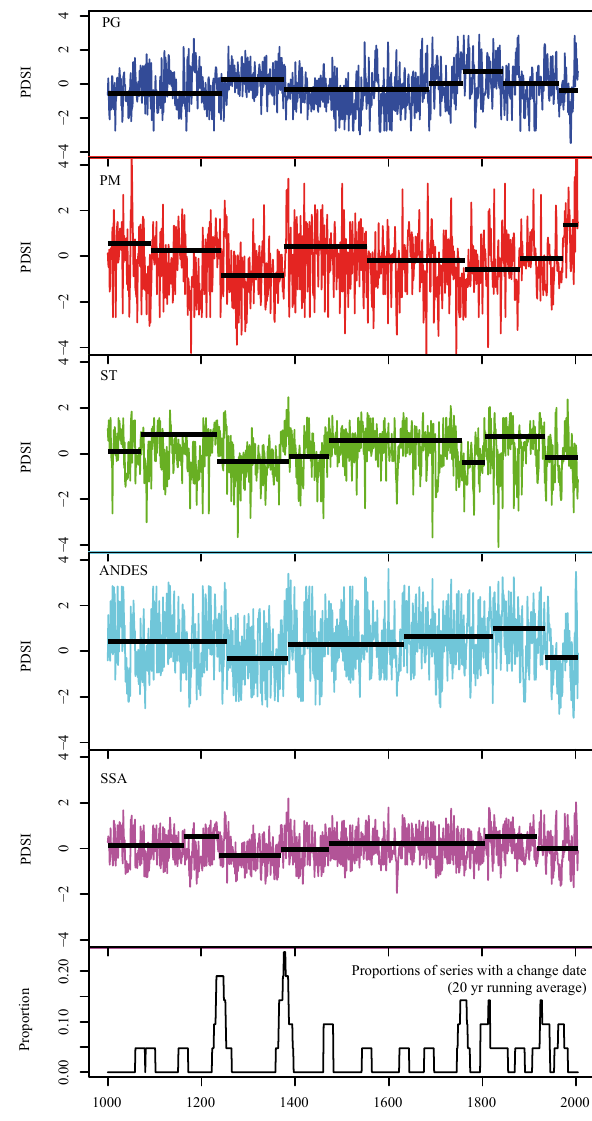
Fig. 11. Regime shift detection in summer PDSI series in SSA. The analysis was performed using the Rodionov (2004) method. Regime shift detection is based on a sequential a t-test algorithm.To be detected, a regime needs to be at least 50 yr long. If a regime has less than 50 yr, the method can still allow for its detection; however, the significance required to determine that a date corresponds to a changepoint is adjusted to be inversely related to the length of the regime. The bottom panel corresponds to the 20 yr running proportion of the number of series, recording a changepoint at year t . It gives a general idea of where these changepoints cluster in time. Color code from Fig. 3 is used